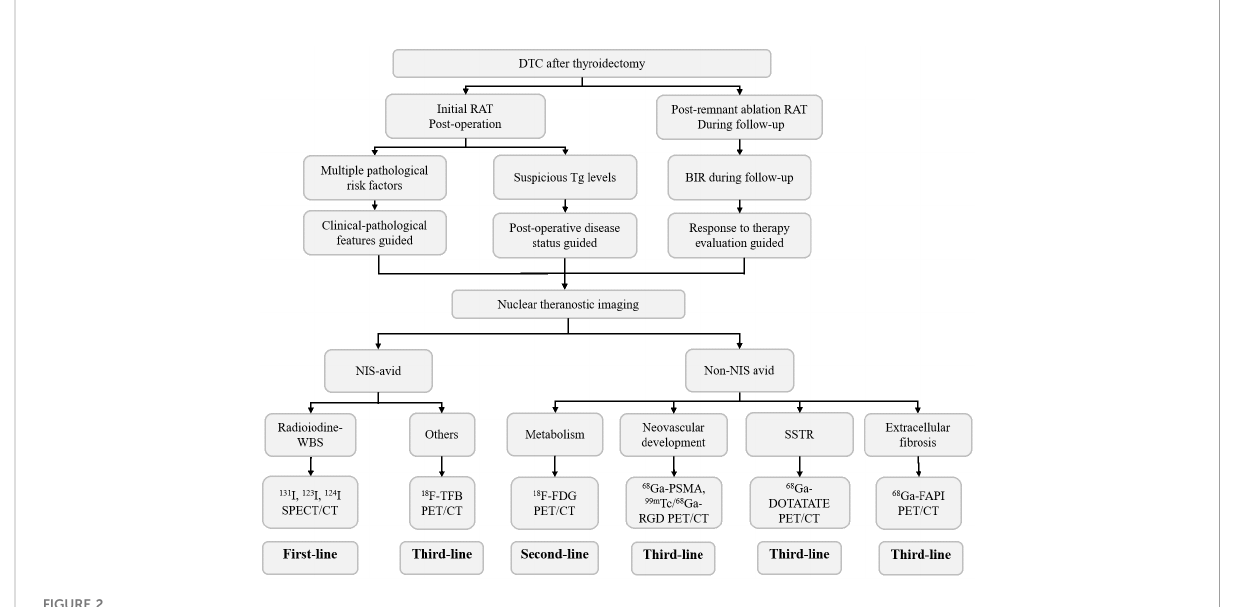
FIGURE 2 Diagram of the RAT decision-making strategy in